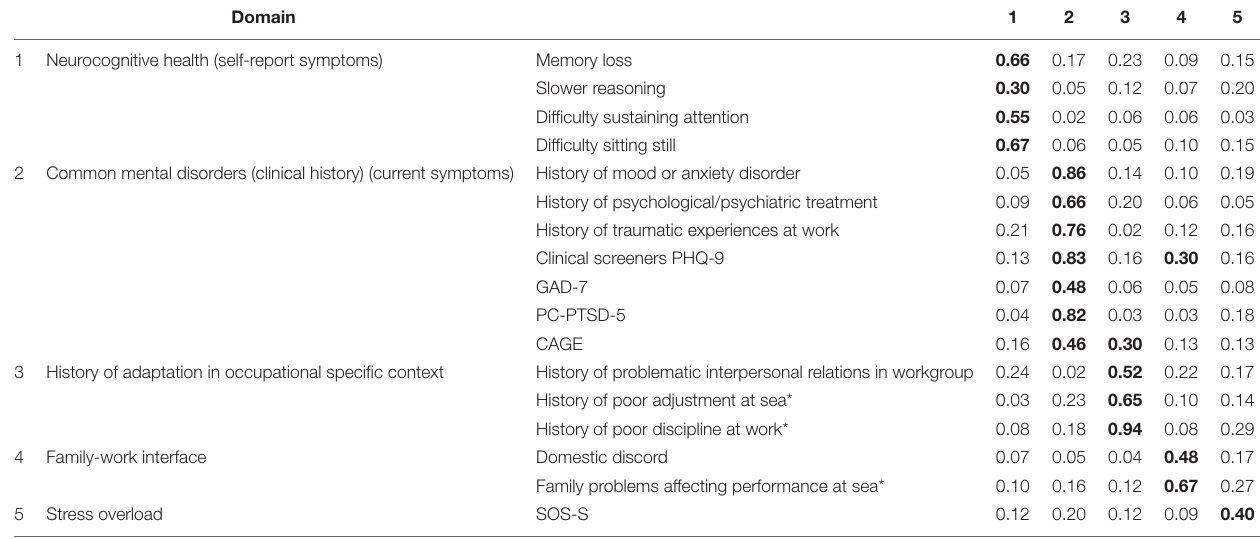
TABLE 3 | Domains of mental health expression associated with psychological adjustment at work*.